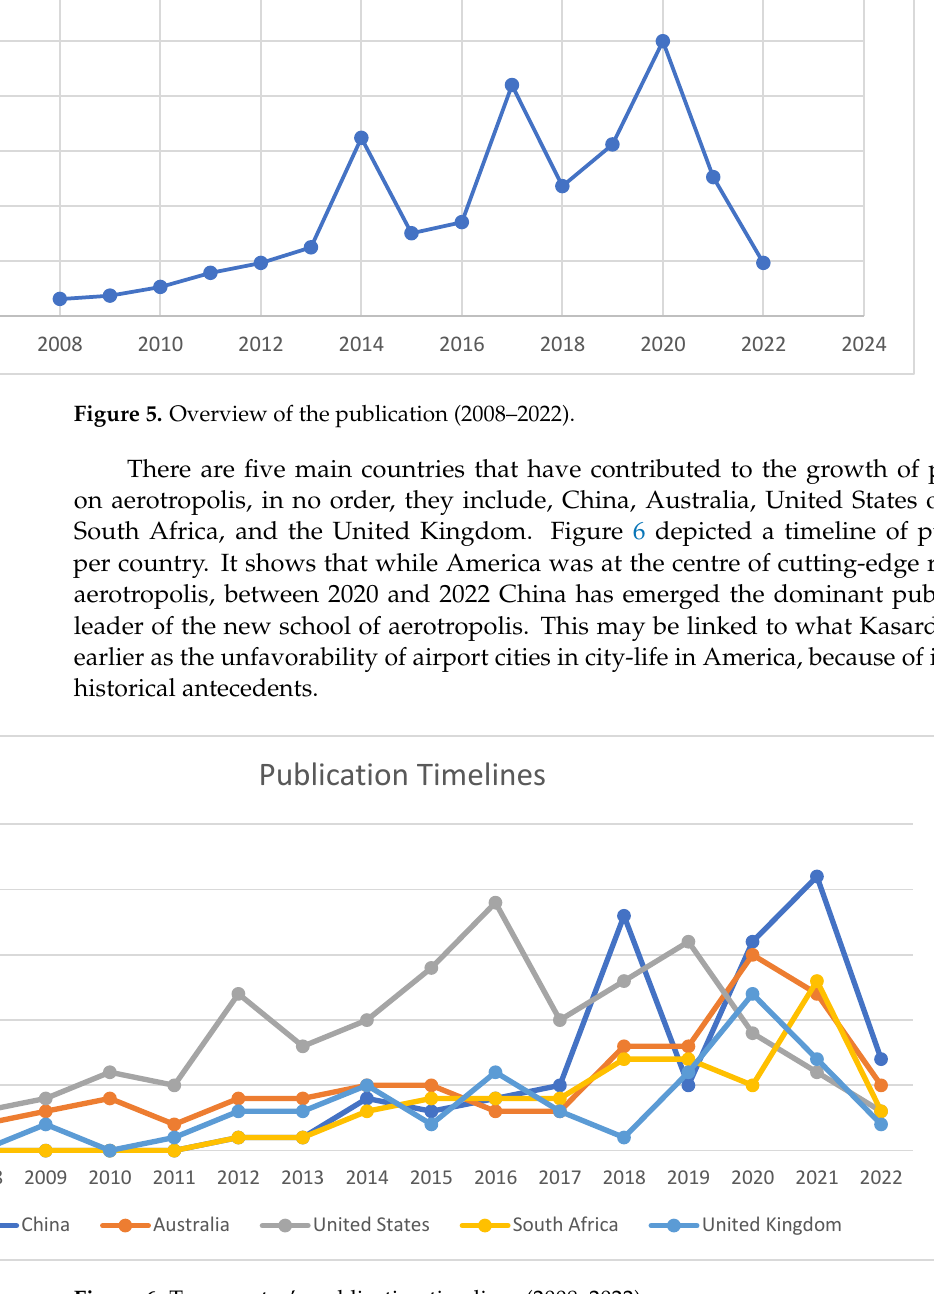
Figure 6. Top country ’ s publication timelines (2008 – 2022) . Figure 7 demonstrated the geography spread of research on aerotropolis. Arguing